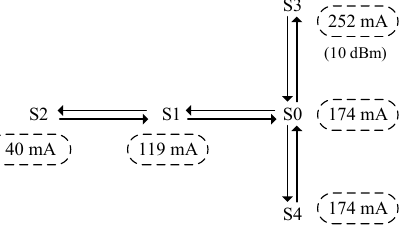
Figure 4. State transition and current consumption.